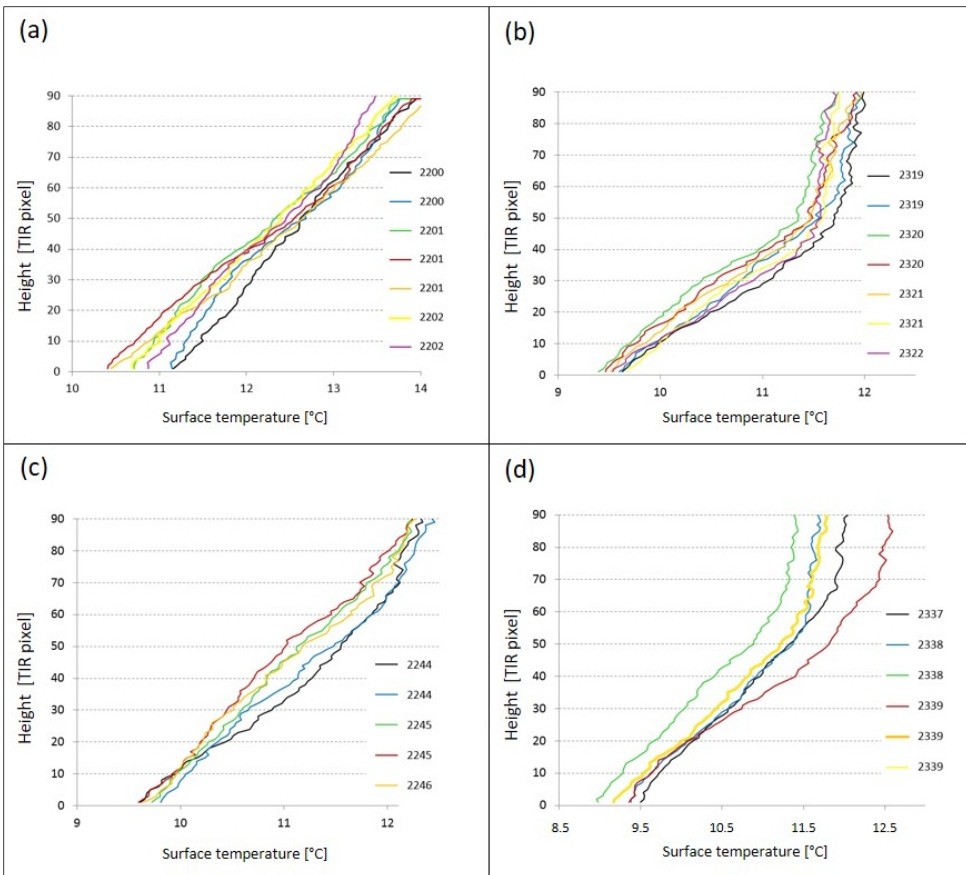
Figure 7. Selected cold-air pulses with vertical PS surface temperature profiles (profile 1, for location see Figure 5) at different time steps while passing the PS on 23 July 2012 with 90 TIR data points (pixel) for a height of 150 cm starting at 20 cm above ground: ( a ) pulse maximum at 22:12 local time (LT); ( b ) pulse maximum at 23:23 LT; ( c ) pulse maximum at 22:45 LT; ( d ) pulse maximum at 23:38 LT. Note that there are different x-axis values.